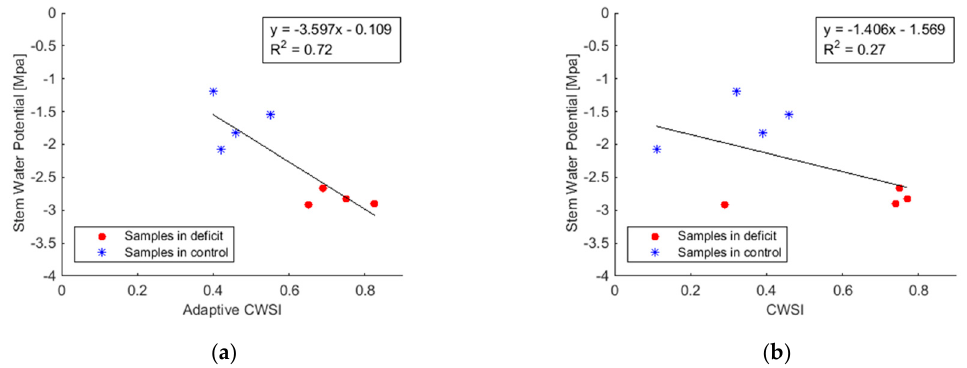
Figure 7. ( a ) Relationship between stem water potential ( ψ stem ) and adaptive CWSI; ( b ) relationship between ψ stem and CWSI of single reference baseline.